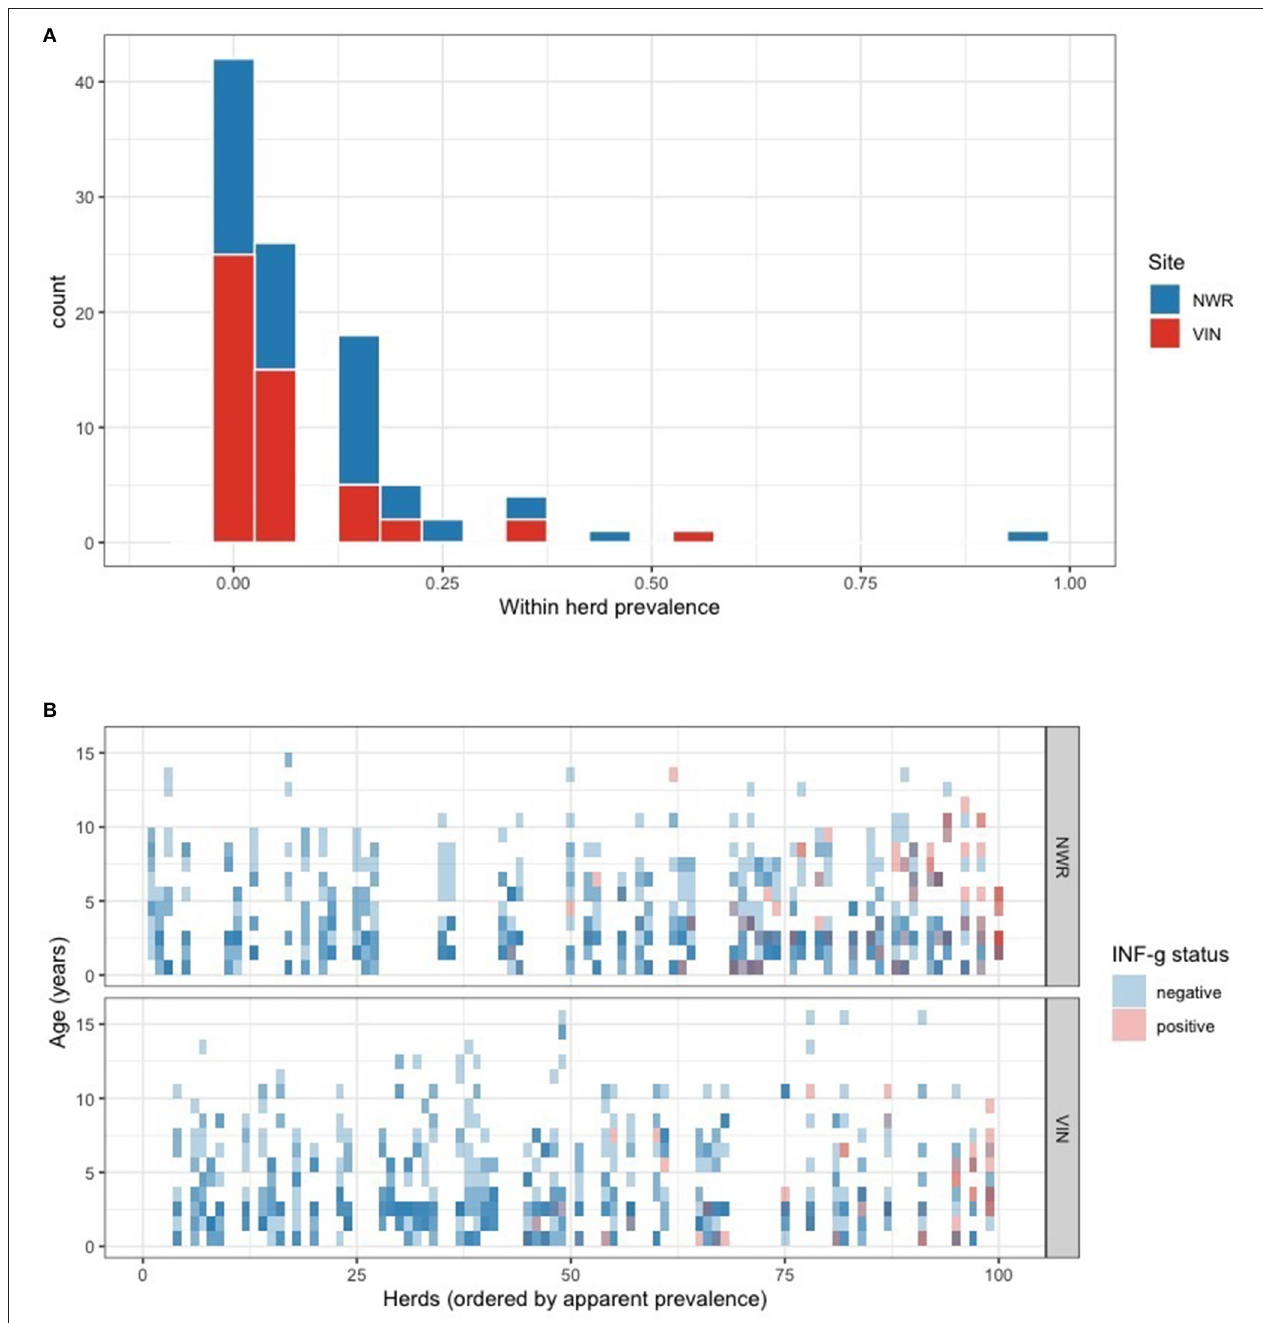
FIGURE 3 | (A) Within-herd IFN- γ positivity prevalence distribution stratified by the two pastoralist sites in the NWR and VIN. (B) Tile plot showing each individual animals IFN- γ positivity status (blue = negative, red = positive). Animals are grouped together in vertical columns according to their herd and the herds are ordered from right to left from highest to lowest within-herd